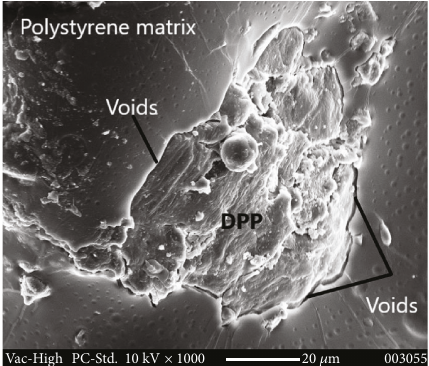
Figure 3: SEM of 30-DPP composite.